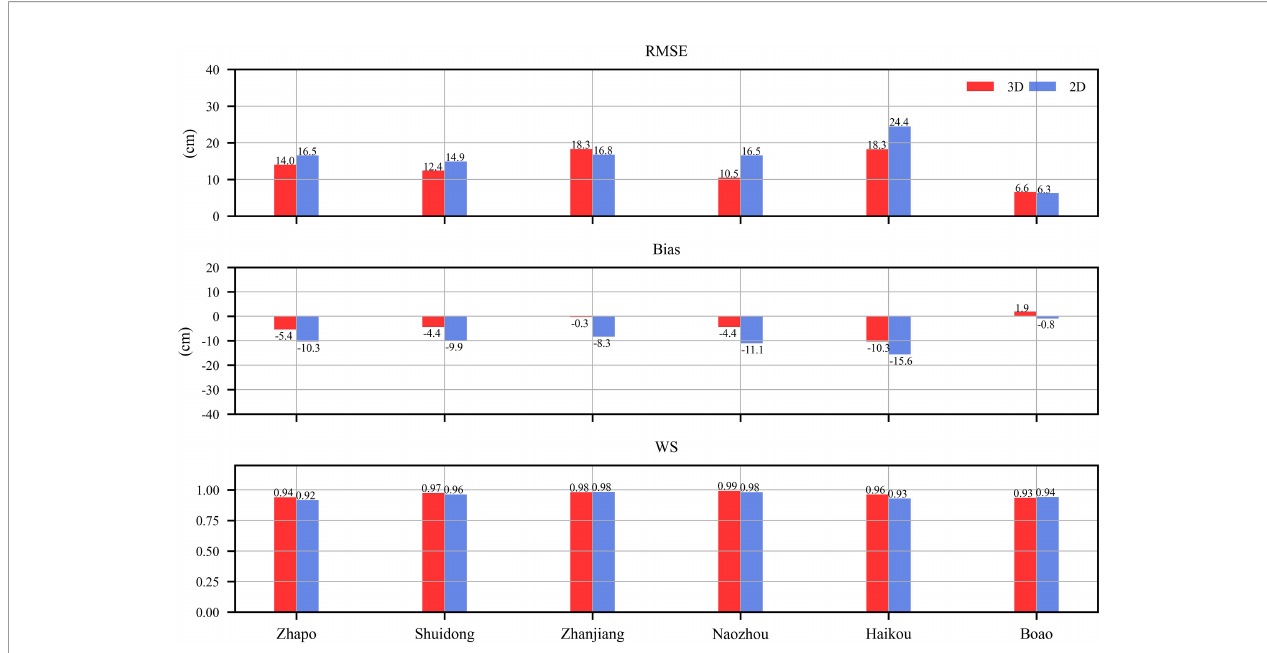
FIGURE 7 | Statistical errors (RMSE and bias) and Willmott skill (WS) between observed and simulated storm surges heights (cm) under the 2-D (blue line) and 3-D (red line) mode conditions at six tide gauge